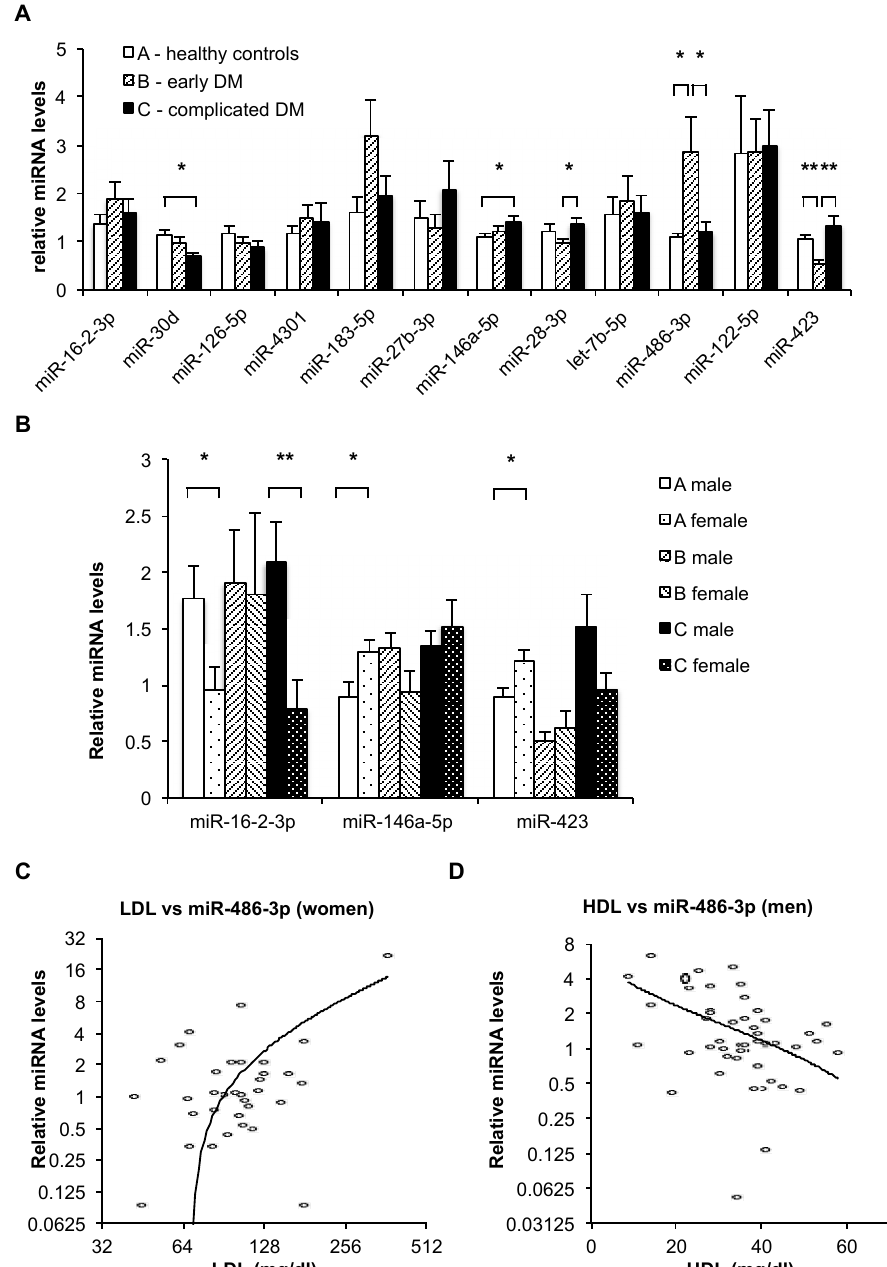
Figure 1. (A ) Relative mean levels of plasma microRNAs in the three subject groups, as measured by quantitative reverse transcription and polymerase chain reaction (qRT-PCR). The data are normalized (the levels of each miRNA can be compared between groups, but the levels of different miRNAs cannot be compared). Bars, standard error. N (A) = 30, N (B) = 29, N (C) = 29. *: p < 0.05; **: p < 0.001 ( t -test). ( B ) Relative mean levels of plasma miR-16-2-3p, miR-146a-5p, and miR-423 in the three subject groups stratified by sex, as measured by qRT-PCR. The data are normalized (the levels of each miRNA can be compared between groups, but the levels of different miRNAs cannot be compared). Bars, standard error. Numbers of samples in each category appear in Table 3. *: p < 0.05; **: p < 0.01 ( t -test). ( C,D ) Relative miR-486-3p levels (determined by qRT-PCR) plotted against low-density lipoprotein (LDL) levels in female subjects ( B , n = 36) and against high-density lipoprotein (HDL) levels in male subjects ( C , n = 52). Note logarithmic scale of horizontal axis in B and vertical axis in both B and C, used to improve resolution. Trendlines are